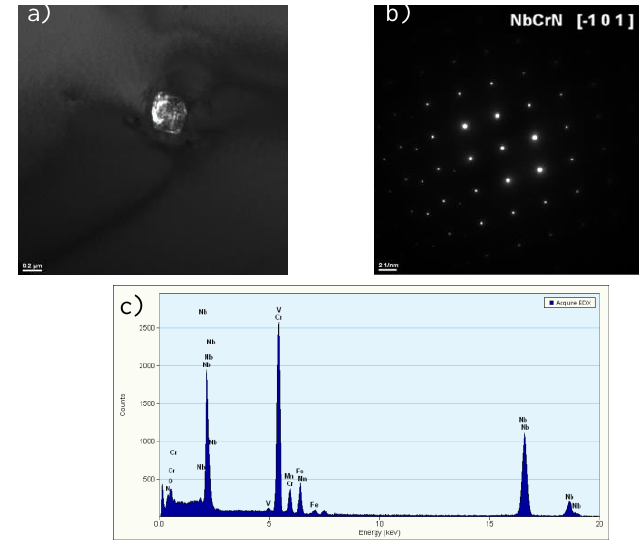
Figure 2. Primary Z-phase precipitate ( a ), resolved di ff raction ( b ), EDS analysis ( c );